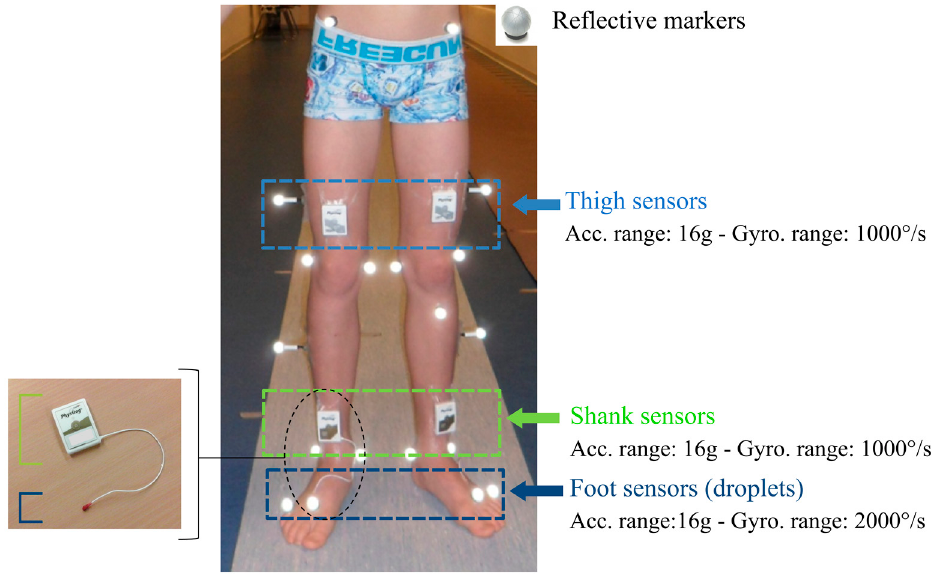
Figure 1. Equipment on the participant’s lower limbs: reflective markers for the optoelectronic system and inertial Physilog sensors for the wearable configurations on the thighs, shanks, and feet. Feet sensors are embedded in a droplet (red PCB resin on the picture on the left), corresponding to deported 6D inertial units connected to the shank sensors.